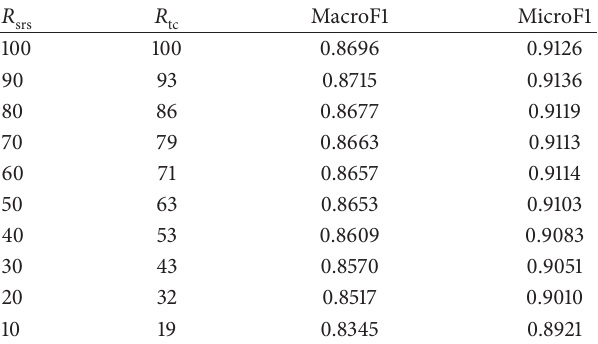
Table 4: Random sampling rate, token compressing rate, and per-